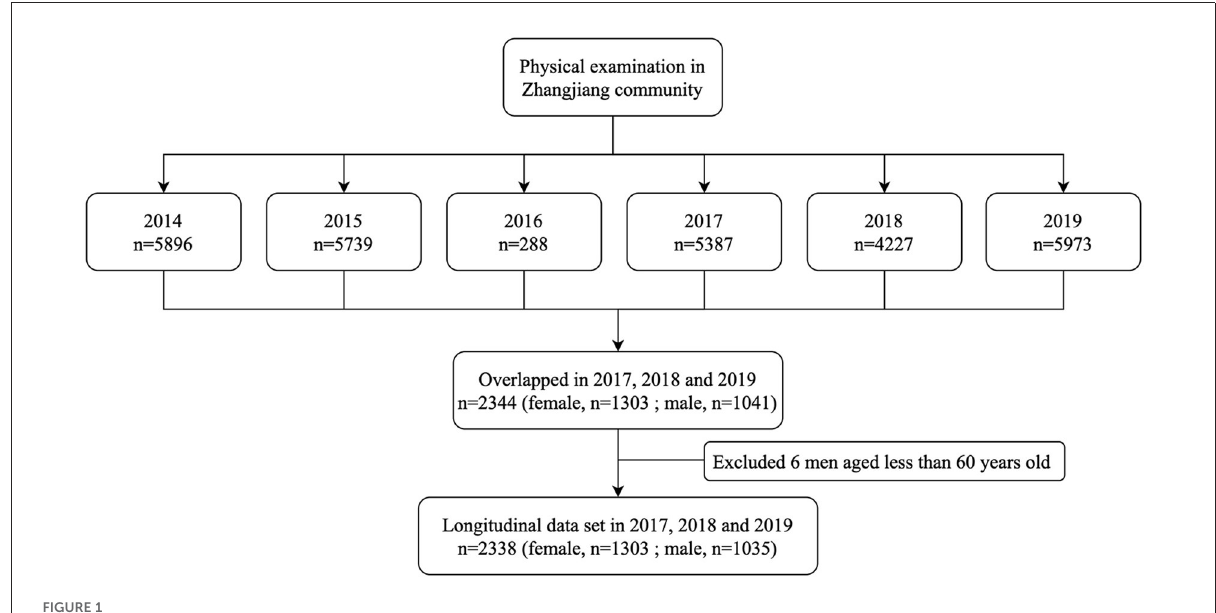
FIGURE1 Study flowchart.